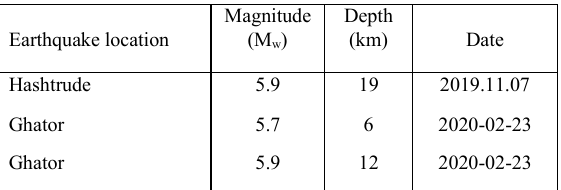
Table 1 2 . The last largest earthquake in NW Iran.